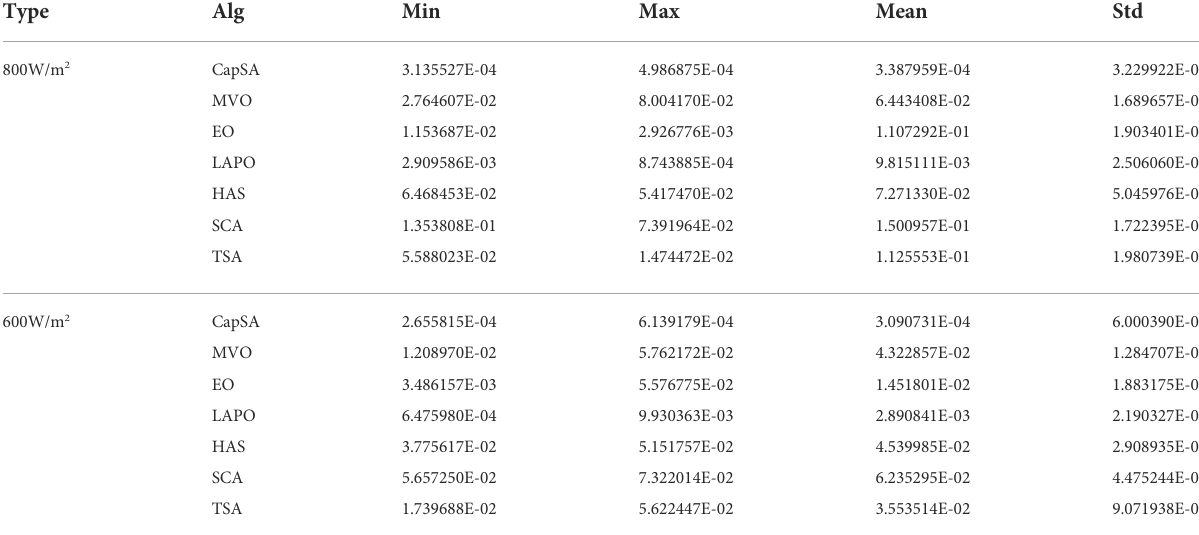
TABLE 12 Statistical parameters of the optimizers applied on KC200GT at different